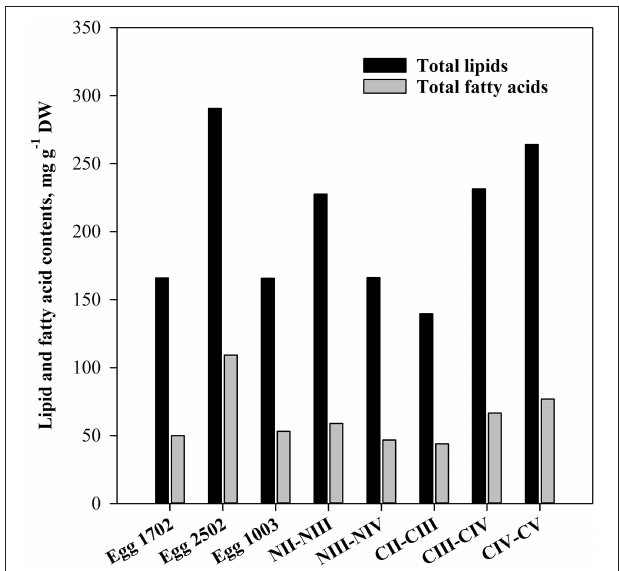
FIGURE 2 | Total lipids and total fatty acids content (mg g − 1 DW) in eggs, nauplii, and copepodites of C. finmarchicus .